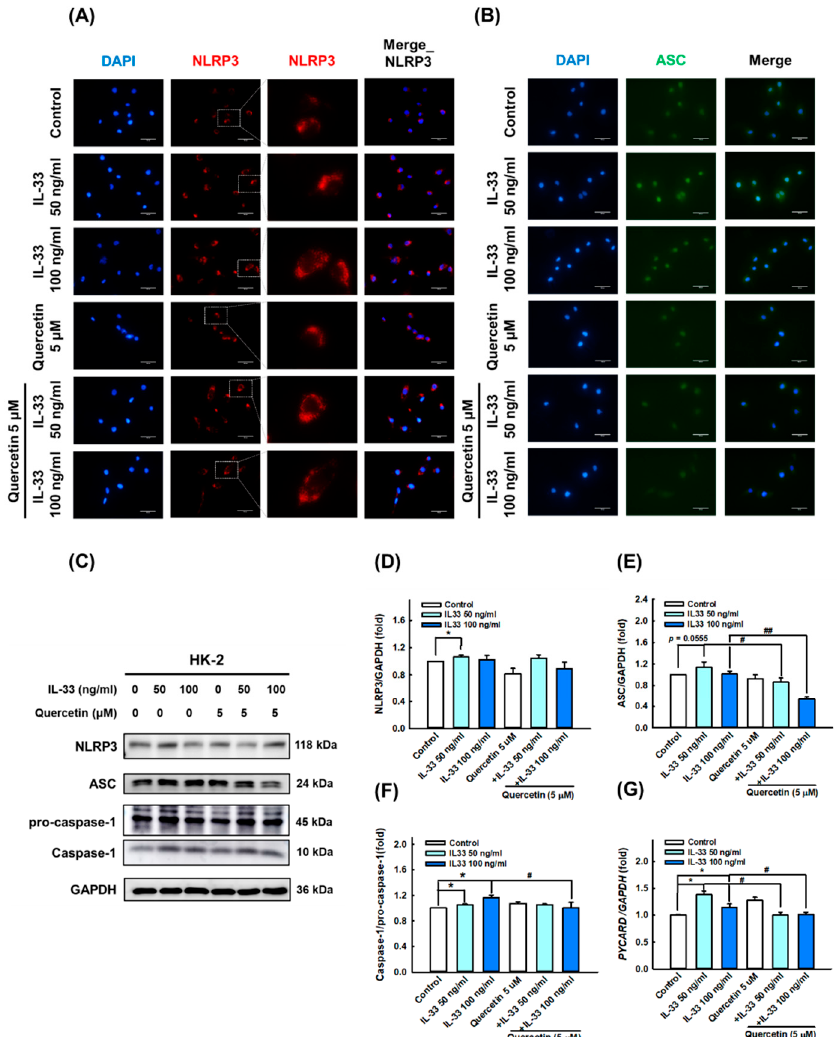
Figure 4. Quercetin reduced inflammasome-associated proteins expression in human renal tubular epithelial cell line. HK-2 cells were co-cultured with 5 μ M quercetin and 50 ng/mL or 100 ng/mL recombinant human IL-33 for 48 h. ( A – B ) Representative photomicrographs showing the immuno- fluorescence staining for NLRP3 (red) and ASC (green) among different groups. Boxed areas are enlarged and presented in the right column. Magnification, 400 × . ( C – F ) Immunoblots and quantitative histograms showing the results of Western blotting analysis for the expression of NLRP3, ASC, and caspase-1 proteins. ( G ) Quantitative histograms showing the results of qPCR analysis for PYCARD mRNA level. Data are expressed as mean ± SD ( n = 3). * p < 0.05 versus control group; # p < 0.05 versus corresponding IL-33-stimulated group; ## p < 0.001 versus corresponding IL-33-stimu- lated group.